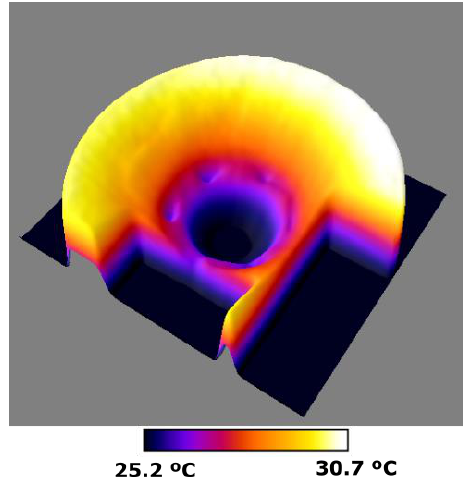
Figure 25. 3D representation of the thermogram taken with the FLIR T425 camera of Figure 25. The coldest points of the screws that join the disk to the axis of the machine are observed.